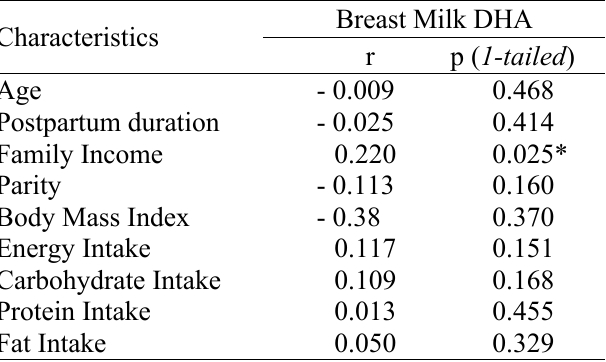
Table 3. Correlations between subject characteristics and breast milk DHA Characteristics